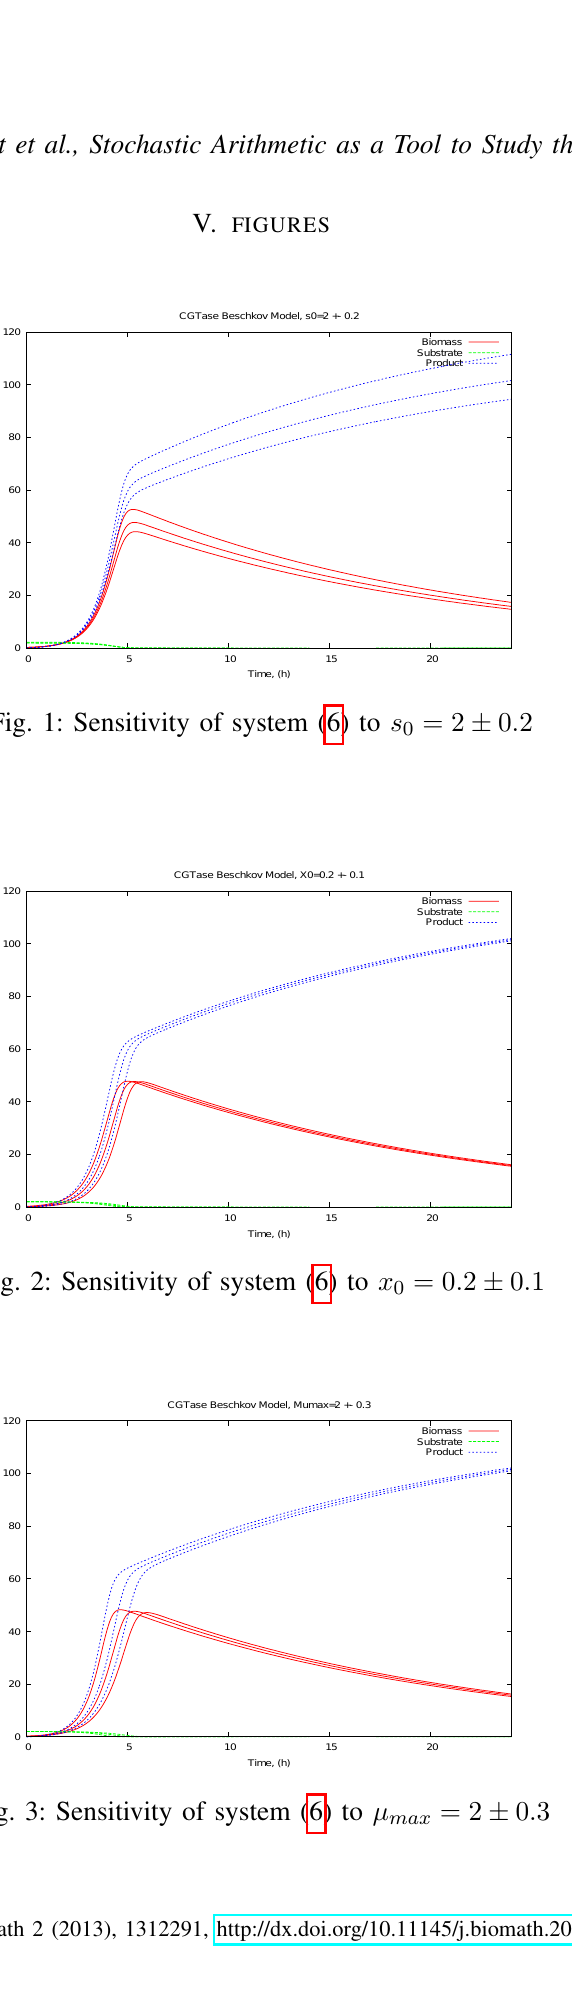
Fig. 6: Sensitivity of system (7) to s 0 = 2 ±